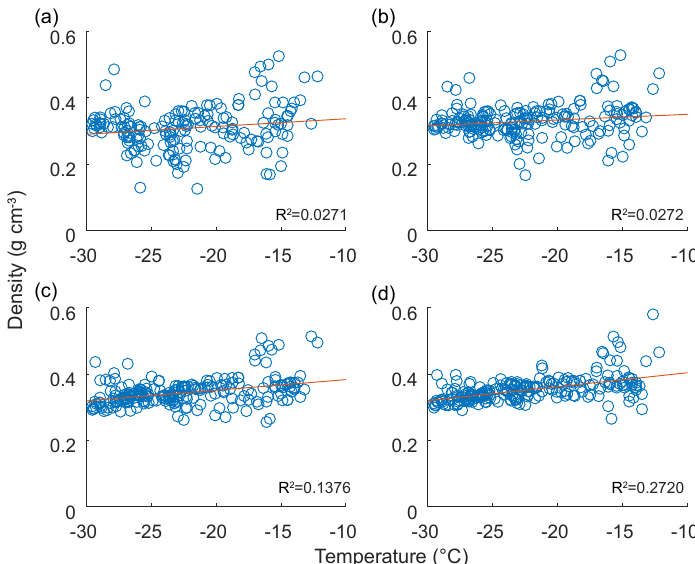
Figure 10. Scatterplot showing the MAR 3.5 modeled mean annual 3m air temperature in the year the density was measured compared to the mean density in the top (a) 10cm, (b) 25cm, (c) 50cm, and (d) 100cm.